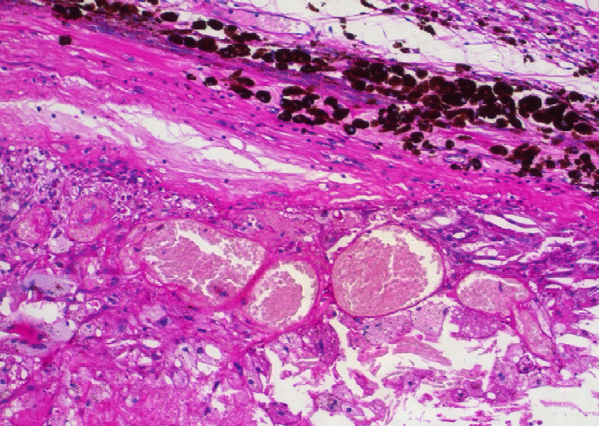
Figure 6 Coats' disease: histopathological findings. Telangiectasic reti-